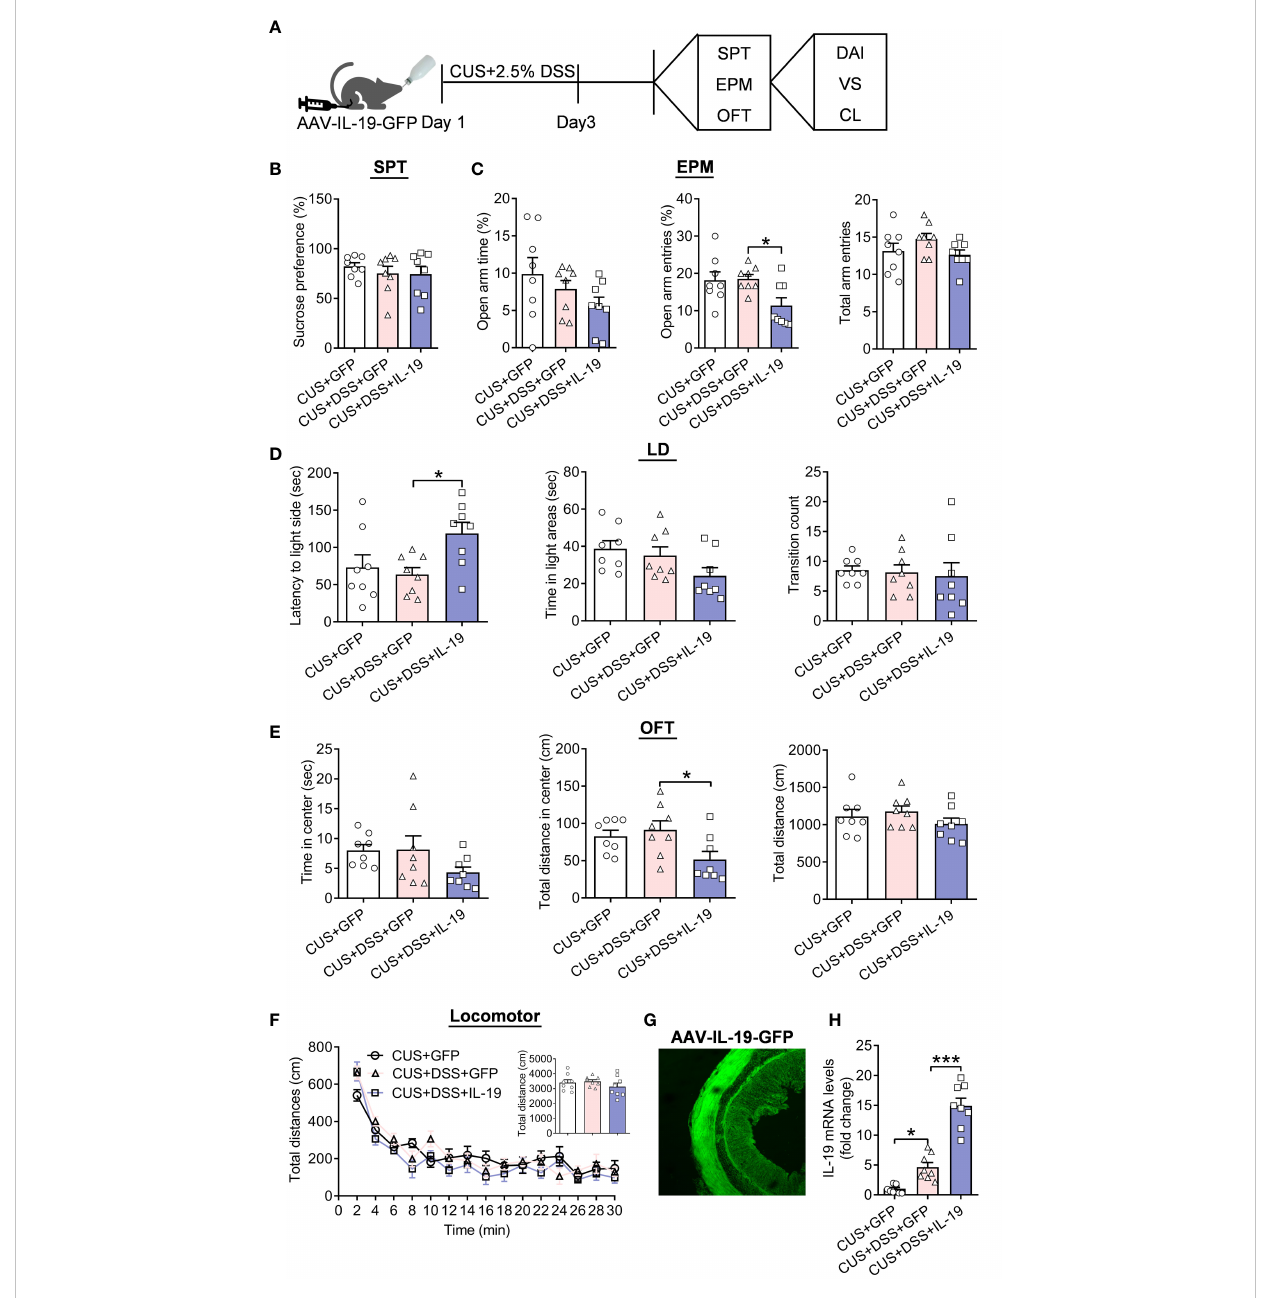
FIGURE 6 The effect of colonic IL-19 overexpression in depression/anxiety-related behaviors and colitis in the DSS/CUS treated mice. (A) Schematic diagram of experimental designs. (B) Sucrose preference test (SPT). (C) Elevated plus-maze test (EPM). (D) Light-dark (LD). (E) Open- fi eld test (OFT). (F) Locomotor activity. (G) Representative image showing the expression of AAV-IL-19-GFP. (H) The IL-19 mRNA levels in the colon. CUS+GFP group: n=8, CUS+DSS+GFP group: n=8, CUS+DSS+IL-19 group: n=8. * p < 0.05, *** p < 0.01, compared to the control